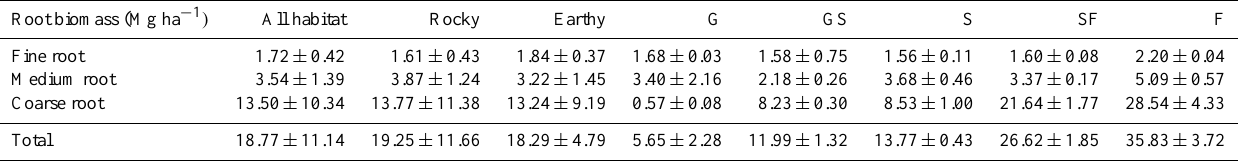
Table 2. Root biomass of karst vegetation in Maolan, southern Guizhou province, SW China. Root biomass (Mg ha − 1 ) All habitat